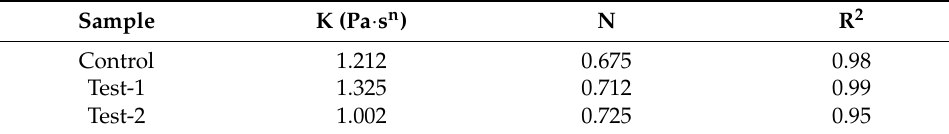
Figure 1. Rheological characteristics—( a ) steady shear (viscosity vs. shear rate) and ( b ) (shear stress vs. shear rate)—of different edible films. Control (pectin+ glycerol); test-1 (flaxseed + pectin + glycerol); test-2 (flaxseed + glycerol). Table 3. Rheological parameters of edible films fitted to power law